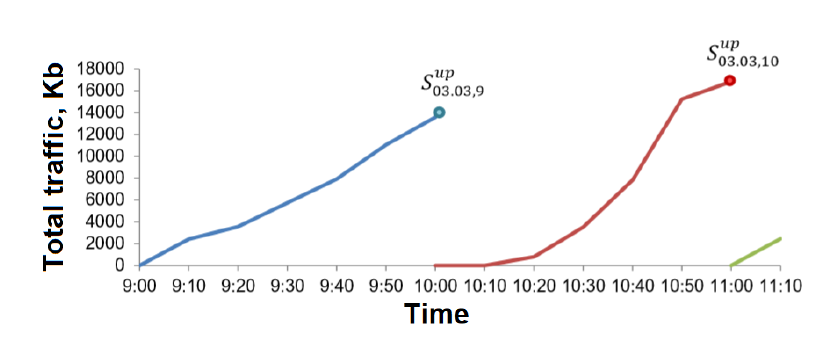
Figure 2. The principle of data accumulation during monitoring. Table 3. Part of the log